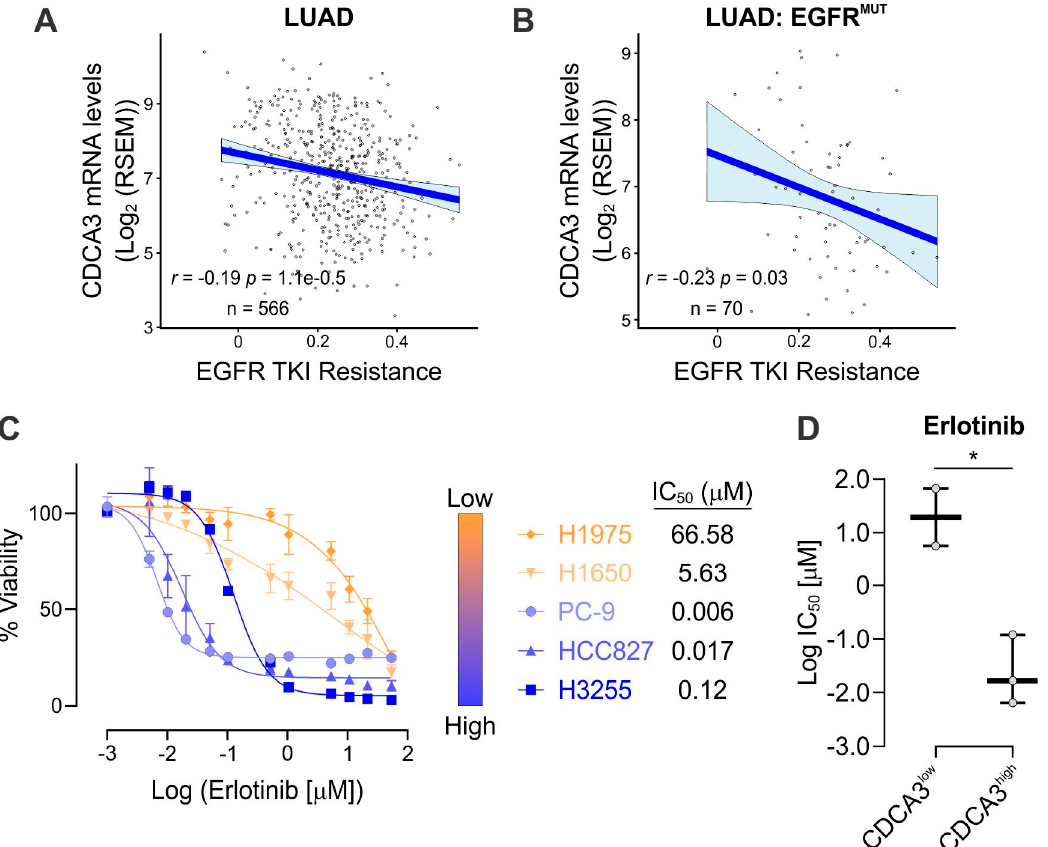
Figure 3. CDCA3 correlates with sensitivity to EGFR TKI. ( A , B ) Scatter plots showing linear regression analysis of The Cancer Genome Atlas (TCGA) RNAseq datasets assessing the correlation between CDCA3 levels and WikiPathways of TKI resistance in ( A ) adenocarcinoma (LUAD) and ( B ) EGFR mutant LUAD. R and p values determined according to Spearman’s rank correlation. ( C ) Left panel, Dose–response curves for five EGFR mutant NSCLC cell lines treated with escalating doses of erlotinib. Cells were treated with erlotinib for 72 h before assessing cell viability. Right panel, Cell lines ranked by CDCA3 protein levels where erlotinib potency values (IC 50 ) were calculated using GraphPad Prism and listed for each cell line. n = 4. ( D ) Box and whisker plot showing erlotinib potency (log IC 50 value) in CDCA3 low and CDCA3 high EGFR mutant cell lines (unpaired Student’s t test, * p = 0.0187).